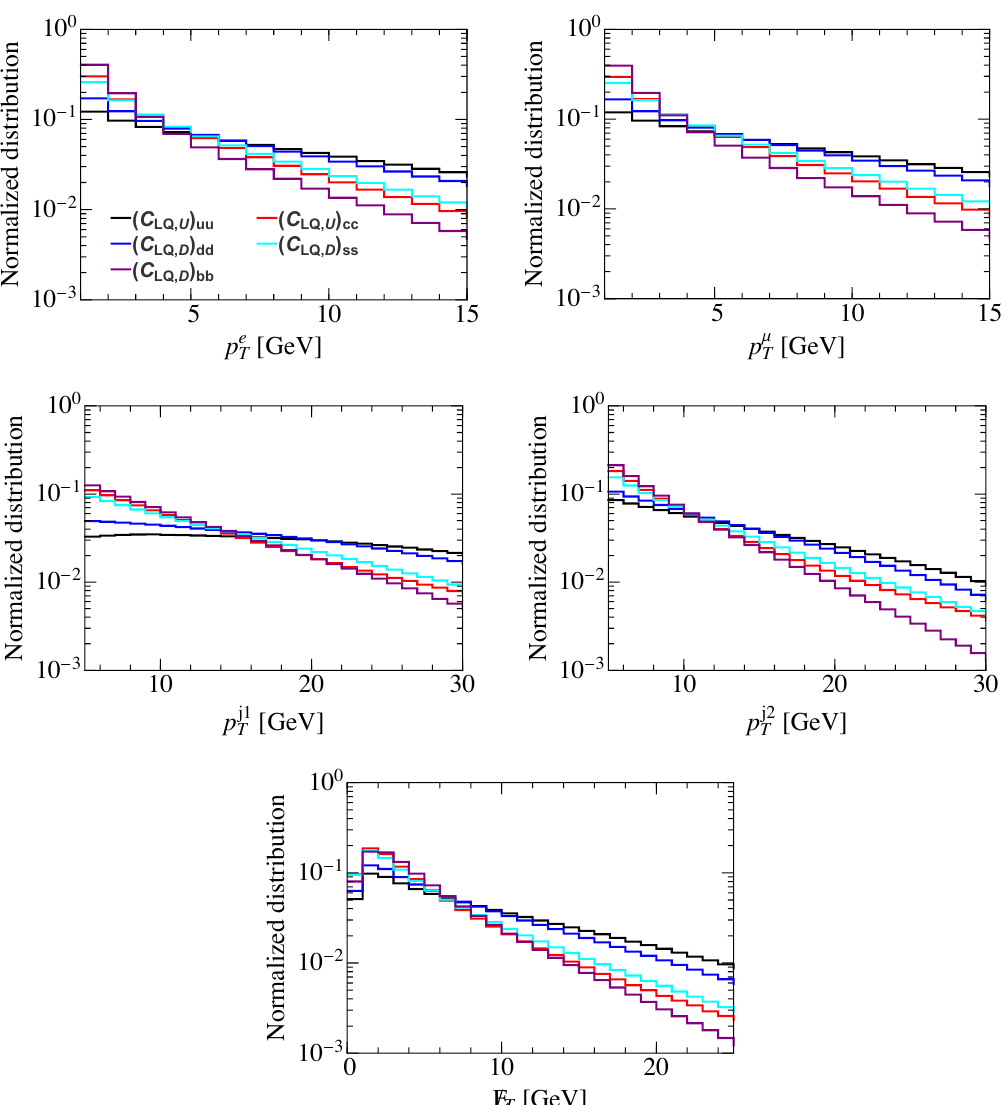
Figure 4 . Electron, muon, leading and subleading jet p T distributions and missing energy dis- tribution induced by four-fermion operators with different flavor components at the EIC, with √ E e = 20 GeV and E p = 250 GeV ( S = 141